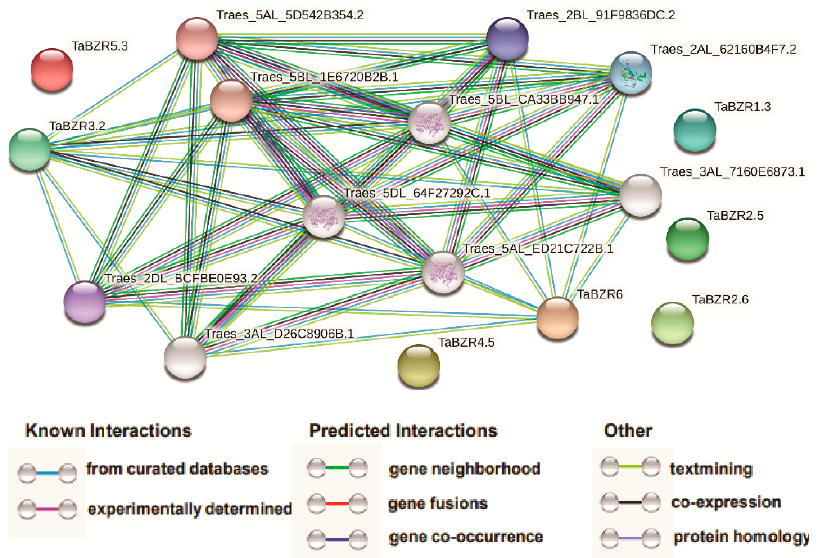
Figure 10. Protein-protein interaction analysis of TaBZRs proteins. Protein-protein interaction network produced by STRINGV9.1. Each node represents a protein, and each edge represents an interaction, colored by evidence type.